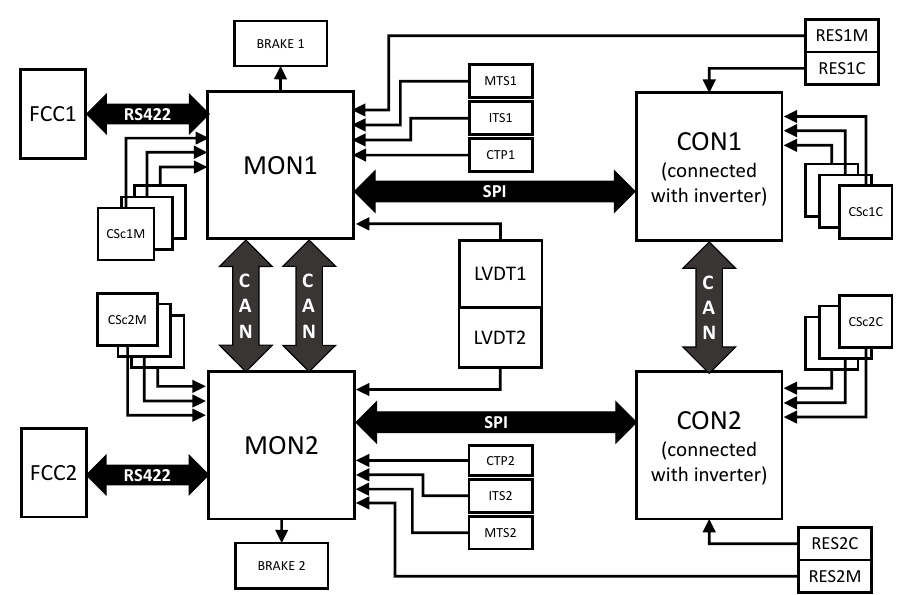
Figure 2. Block diagram representing the data exchange among the dual CON-MON ECUs.